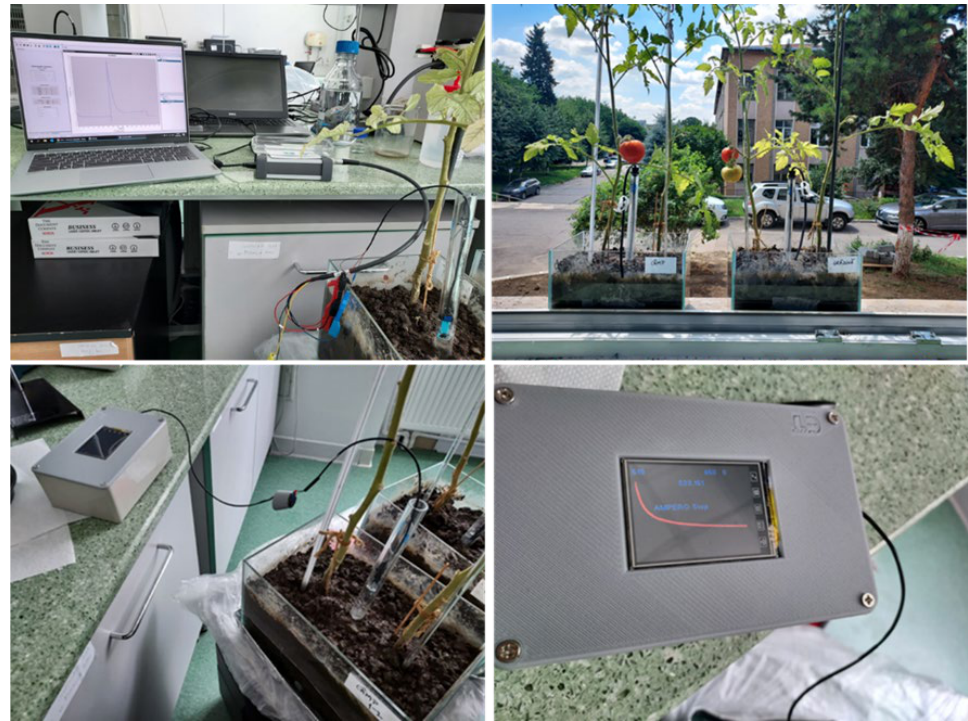
Figure 12. Nitrite determination in soil solutions using a portable miniaturized electrochemical de- tector and a flexible MWCNT -CS/SPE sensor. detector and a flexible MWCNT-CS/SPE